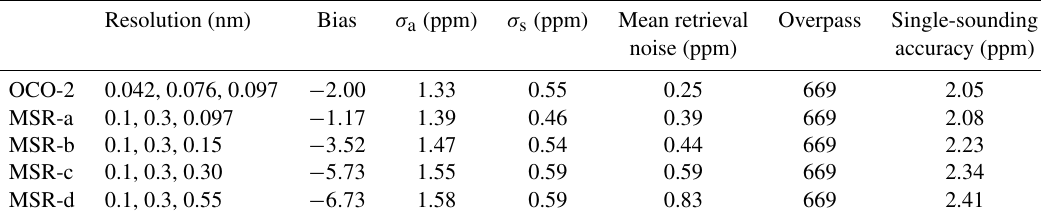
Table 6. Same as Table 5, but for the intersection between OCO-2 and MSR retrievals. Resolution (nm) Bias σ a (ppm) σ s (ppm) Mean retrieval